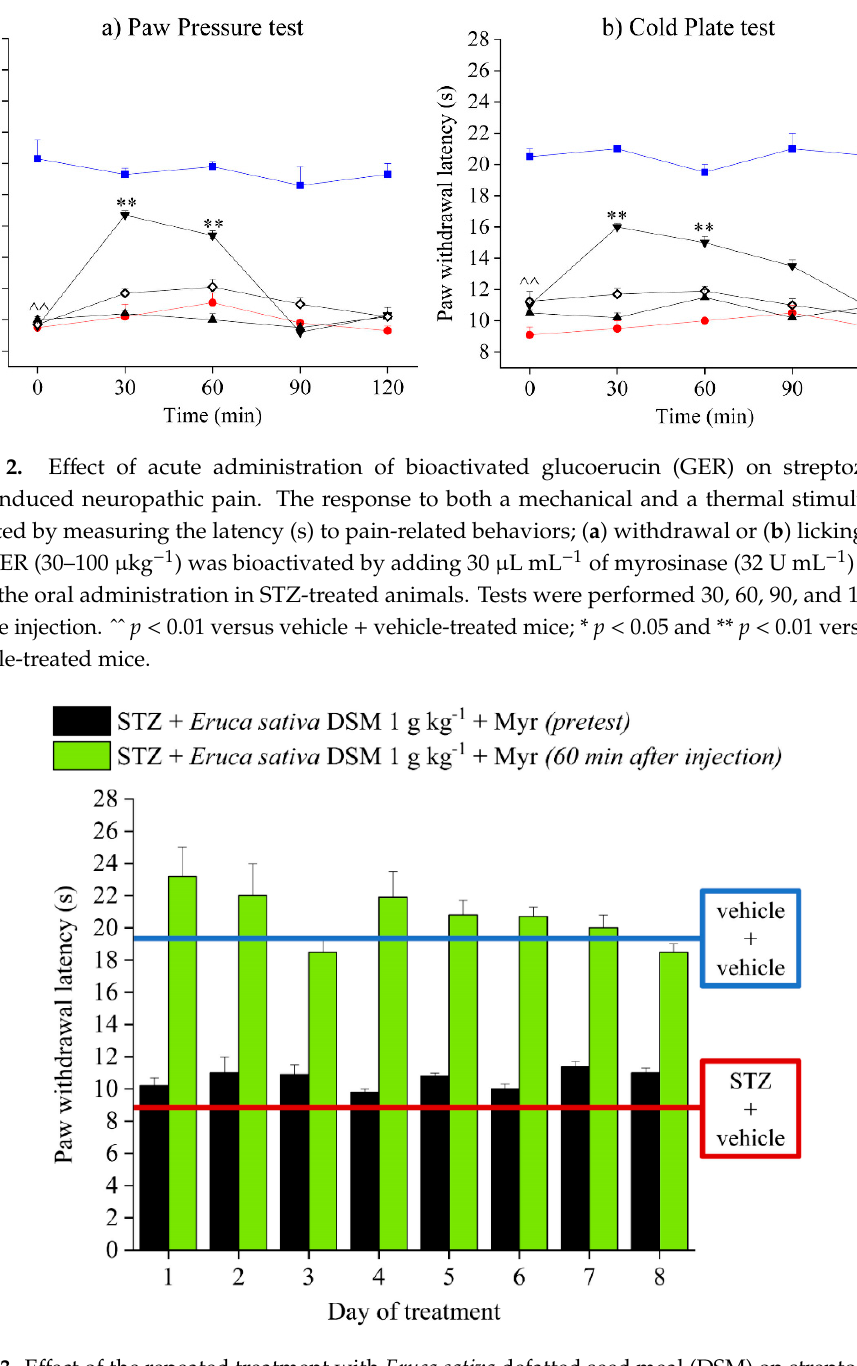
Figure 3. Effect of the repeated treatment with Eruca sativa defatted seed meal (DSM) on streptozotocin (STZ)-induced neuropathic pain. The response to a mechanical stimulus was evaluated by measuring the latency (s) to pain-related behaviors (paw withdrawal). The myrosinase (Myr)-bioactivated Eruca sativa DSM (1 g kg − 1 ) was administered once daily for 8 consecutive days in STZ-treated animals (once neuropathy was established) and pain threshold was assessed before and 60 min after the injection. ^^ p < 0.01 versus vehicle + vehicle-treated mice; * p < 0.05 and ** p < 0.01 versus STZ + vehicle-treated mice.